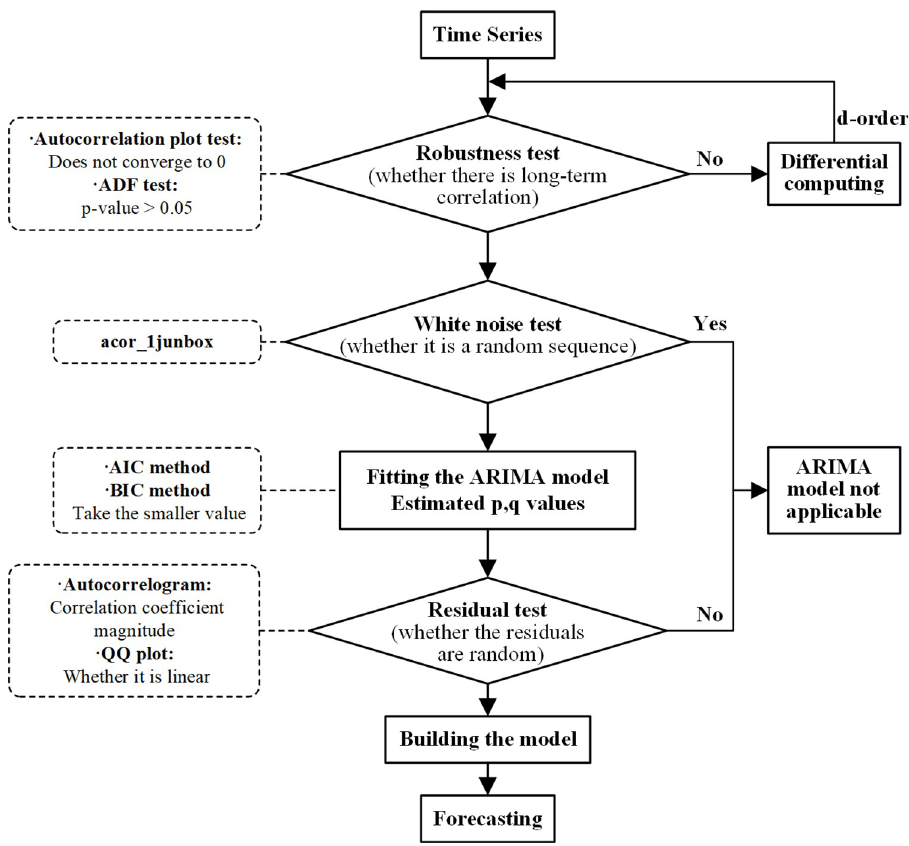
Fig 2. ARIMA model